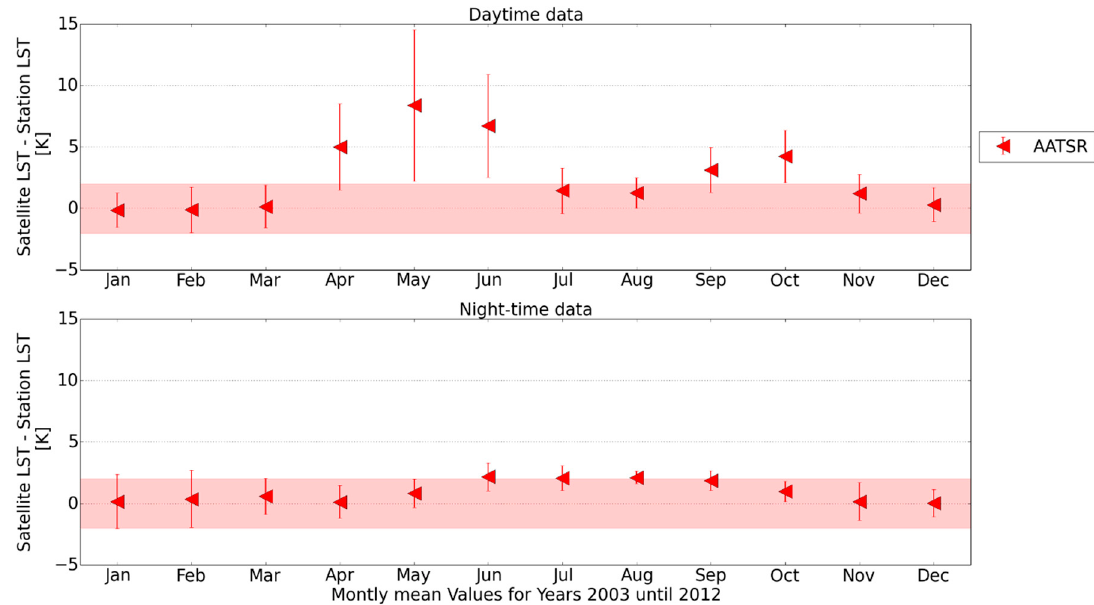
Figure 2. Monthly median accuracies (Advanced Along Track Scanning Radiometer (AATSR) Land Surface Temperature (LST)–Station LST) over Bondville (BND) station for 2003–2012. The ranges shaded in red indicate the accuracy range of ± 2.0 K, the symbols are the medians, and the error bars are the robust standard deviations (STDs).